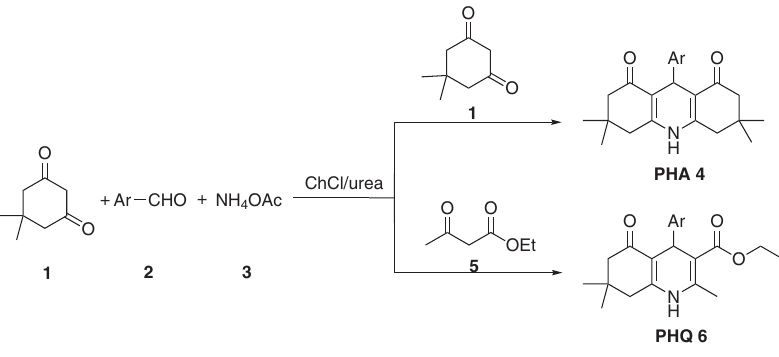
Scheme 1 One-pot synthesis of PHA and PHQ derivatives in